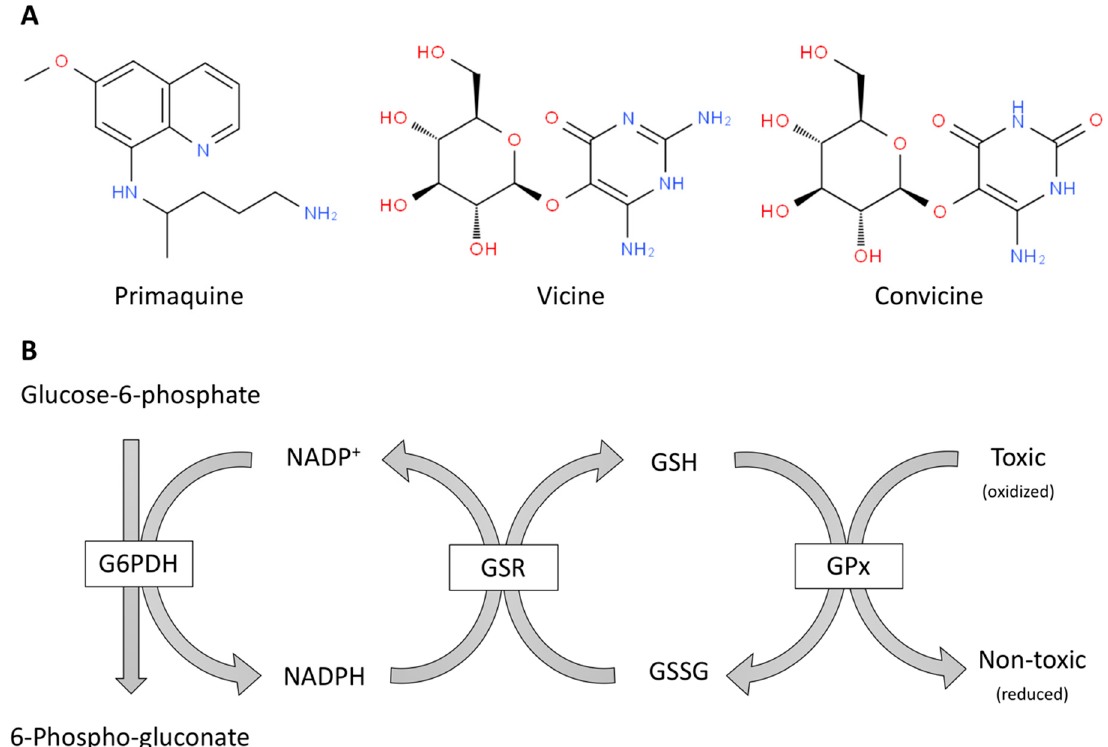
Figure 1. Oxidant molecules ( A ) and simplified scheme of antioxidant defense mechanisms mediated in erythrocytes by glutathione and NADPH ( B ). ( A ) Examples of pro-oxidant toxic molecules for red blood cells from G6PDH deficient patients: a drug, primaquine, and natural compounds from fava beans, vicine and convicine. ( B ) The enzymes are in boxes and the rest are substrates of these enzymes. G6PDH: Glucose-6-phosphate dehydrogenase, GPx: glutathione peroxidase; GSH: glutathione; GSR: glutathione-disulfide reductase; GSSG: glutathione disulfide.